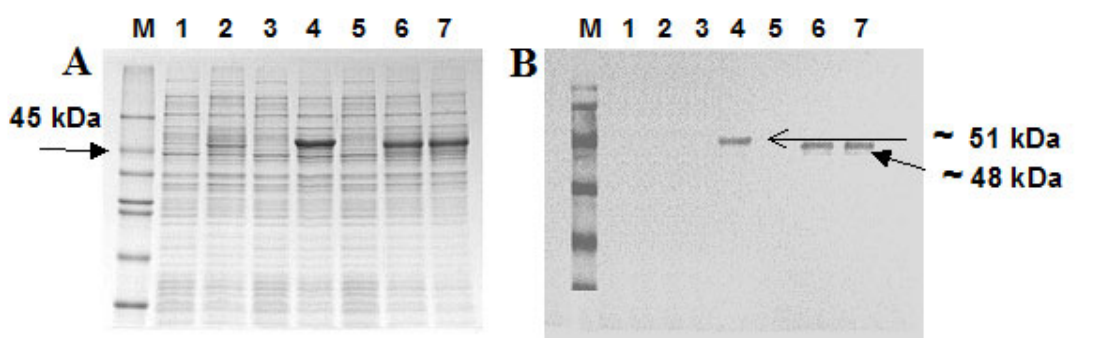
Figure 3. SDS-PAGE (A) and western blot (B) of whole cell extract of Escherichia coli non-assayed with anti-MBP antibody (New England Biolabs, Ipswich, MA, USA). Lines 1, 3 and 5 were loaded with non-induced whole cell extract of bacteria transformed with pREP, pMAL E and recombinant pMAL-2-MBP-GlyTX4, respectively. Lines 2 and 4 were loaded with pREP and pMAL-2 (p2) cultures induced with 10mM IPTG, respectively. Lines 6 and 7 are whole cell culture extracts harboring the recombinant pMAL-2-MBP-GlyTX4 after 4h and 8h of induction with 10mM IPTG, respectively. M = rainbow molecular weight marker (New England Biolabs, Ipswich, MA).